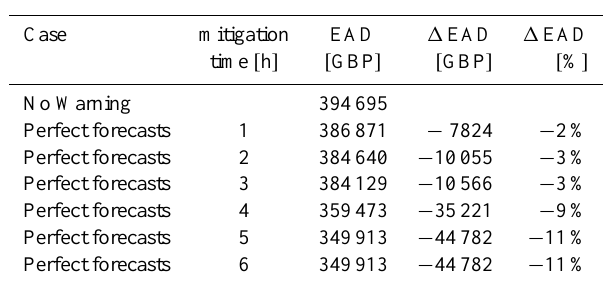
Table 2. Loss reduction in terms of expected annual damage (re- sponse costs not included).